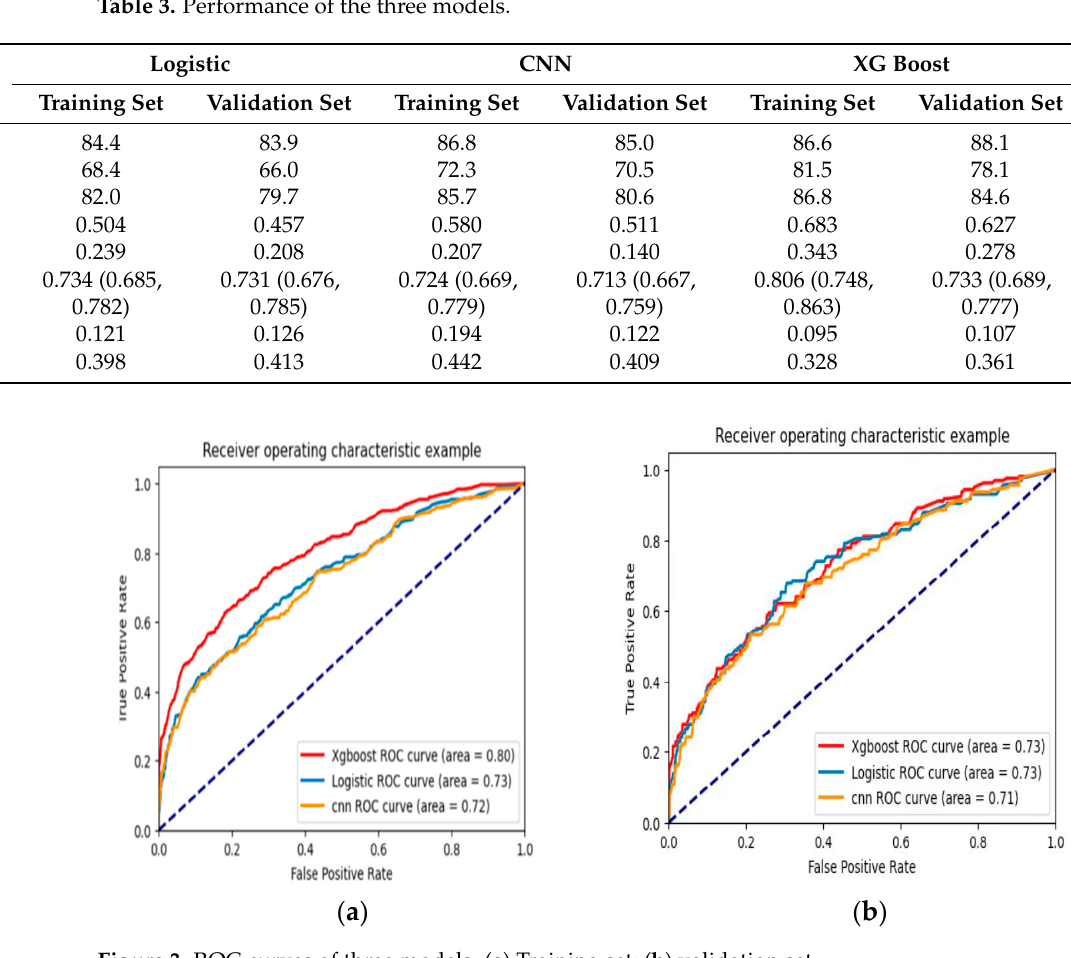
Table 3. Performance of the three models.